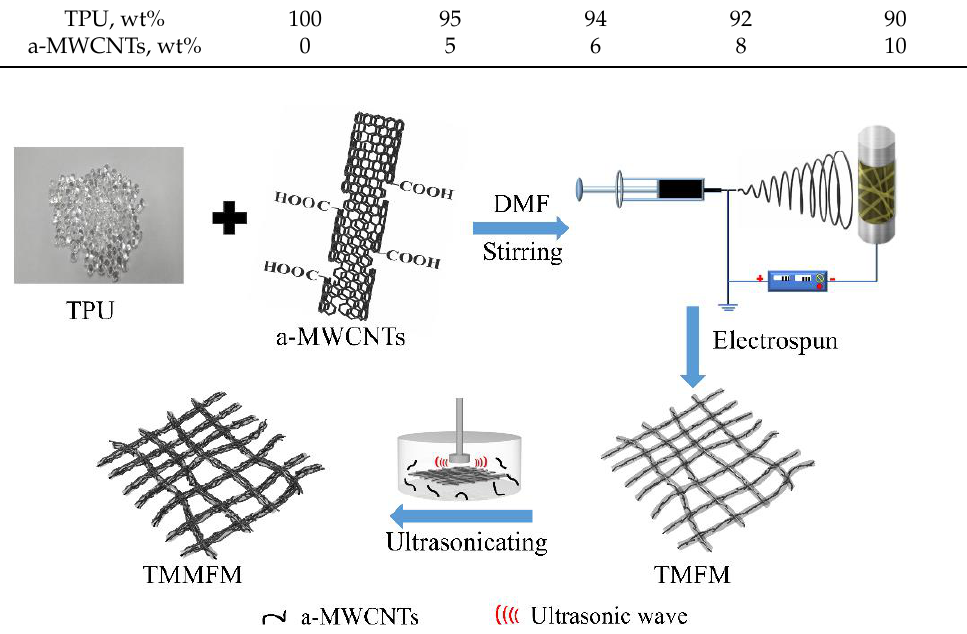
Figure 1. Schematic diagram of preparation of TMMFM.